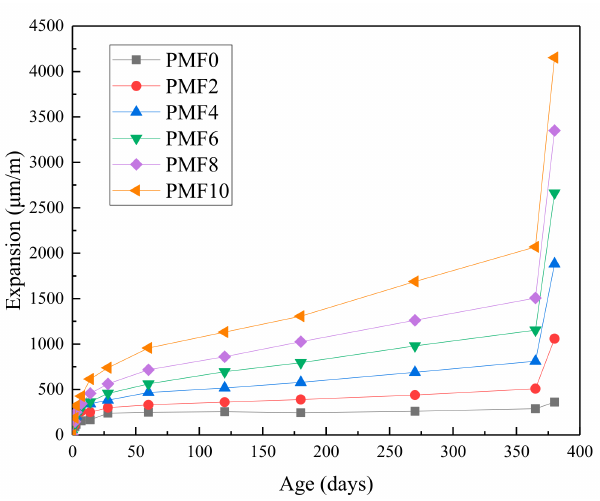
Figure 6. Effect of nano-MgO content on expansion performance of cement